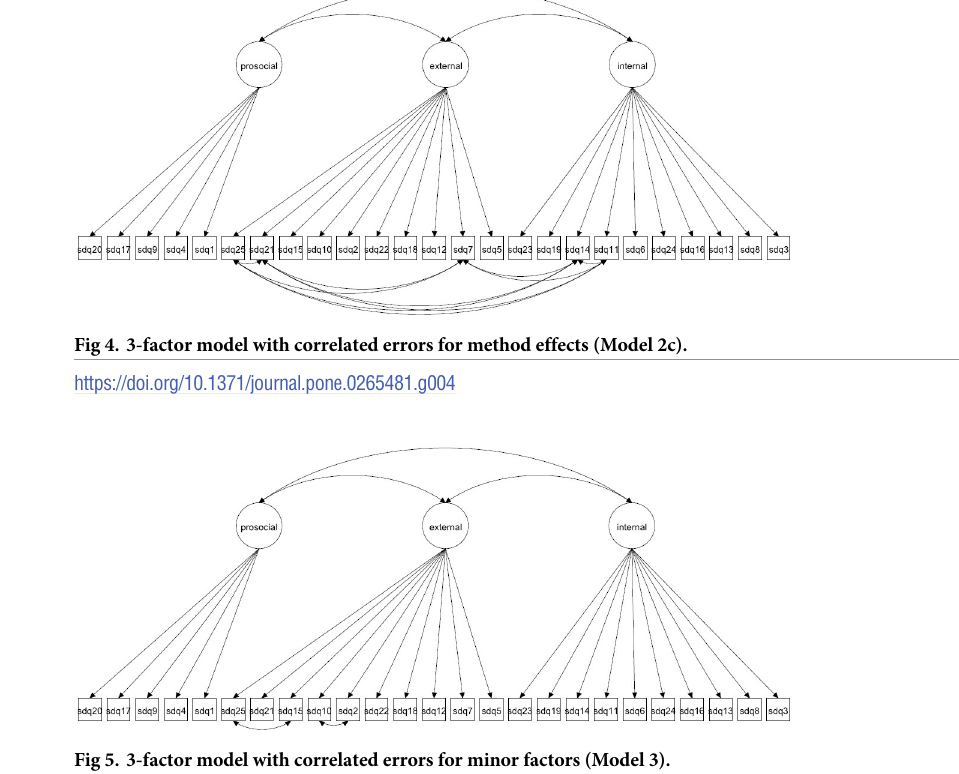
Fig 5. 3-factor model with correlated errors for minor factors (Model 3).